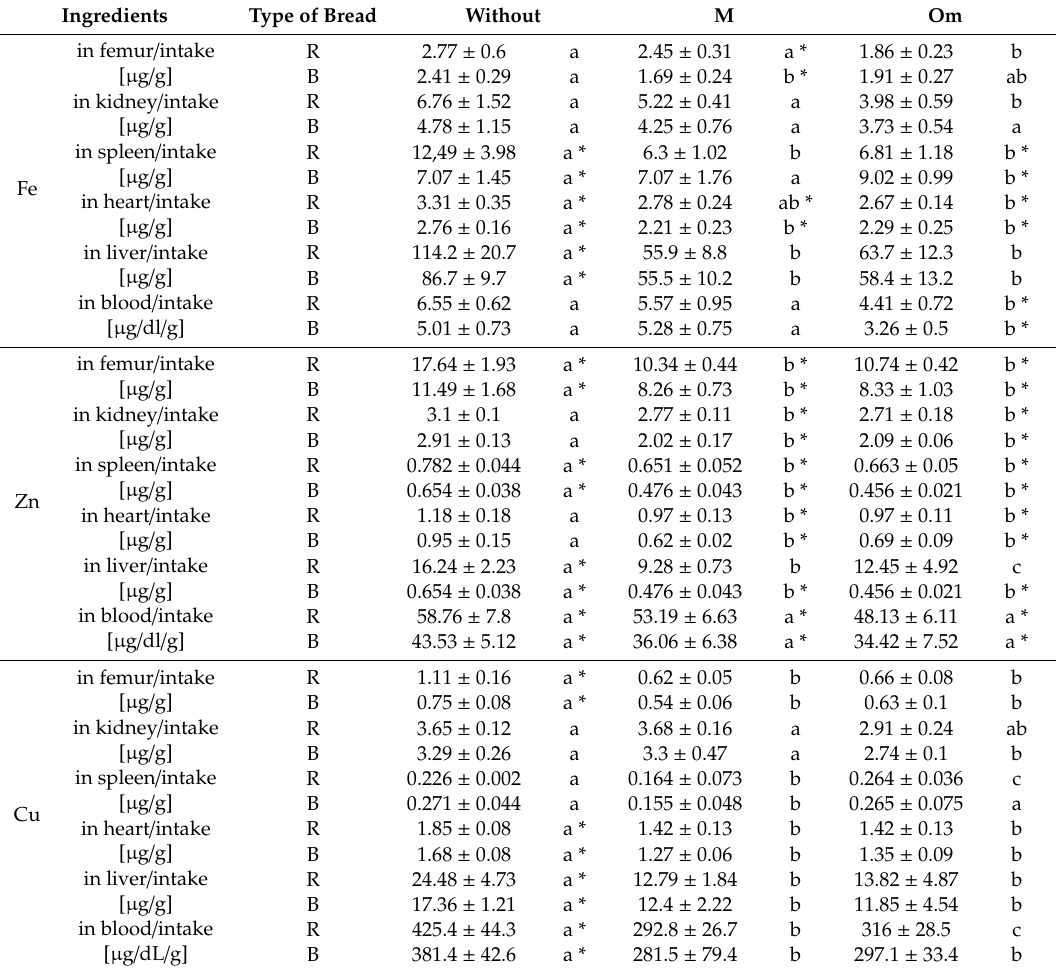
Table 6. The content of minerals in organs in relation to its consumption. Ingredients Type of